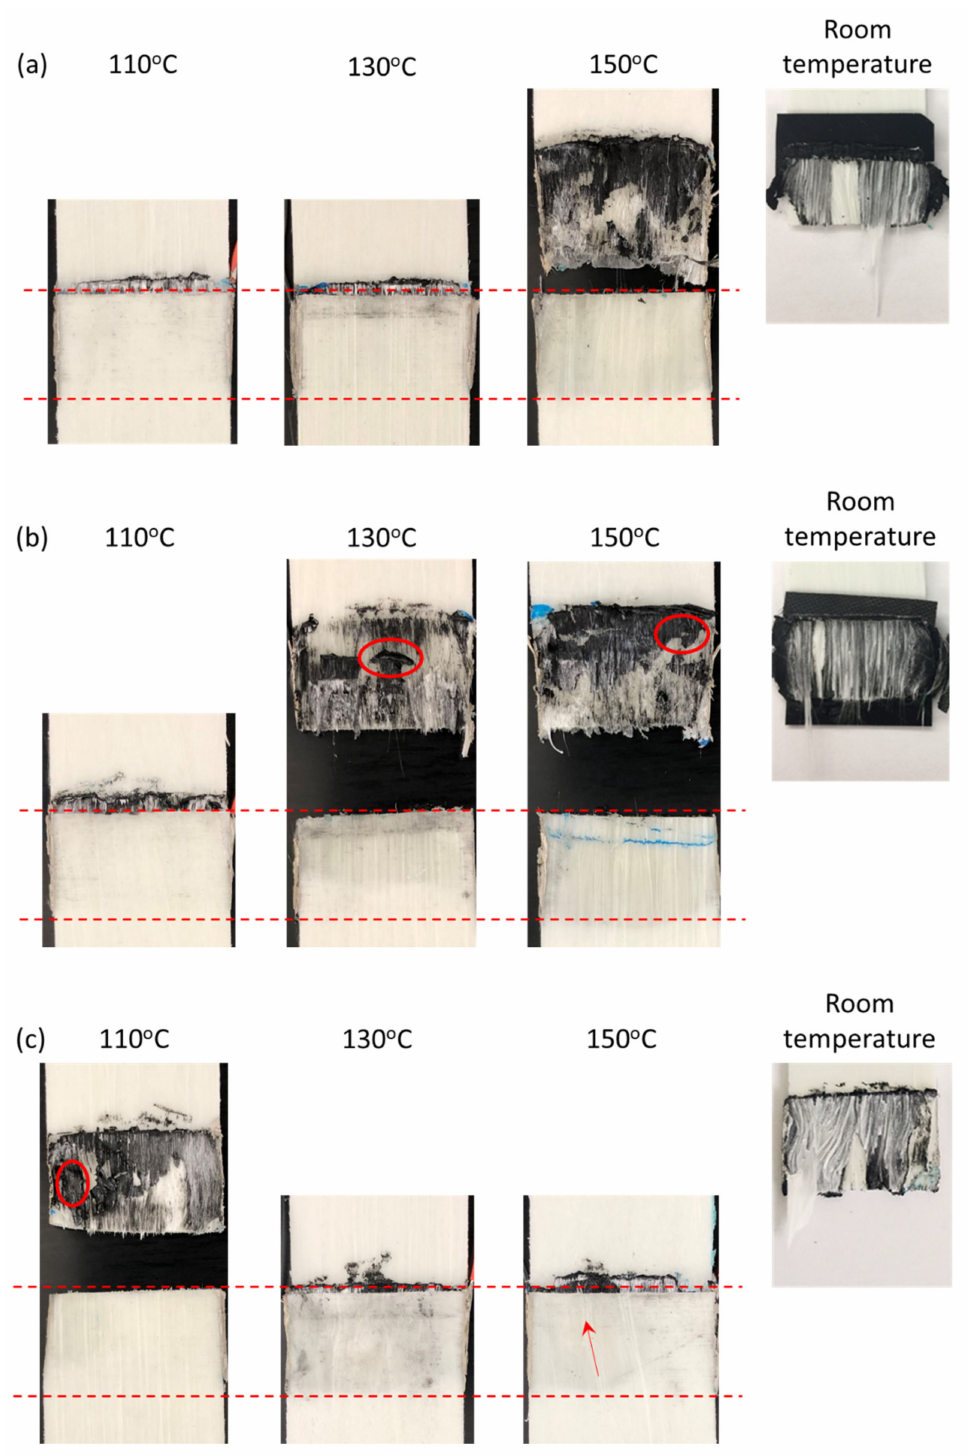
Figure 11. Representative photographic images of welded GF/PP adherends after disassembly procedure: ( a ) 15 wt.% MWCNT/PP film; ( b ) 20 wt.% MWCNT/PP film, and; ( c ) 25 wt.% MWCNT/PP film. The dashed red lines show the location of the overlap for the upper adherend. The circled areas indicate melted nanocomposite films. The arrow in ( c ) shows the location of a crack in the GF/PP adherend, damaged during the disassembly process. Room temperature images reproduced with permission from